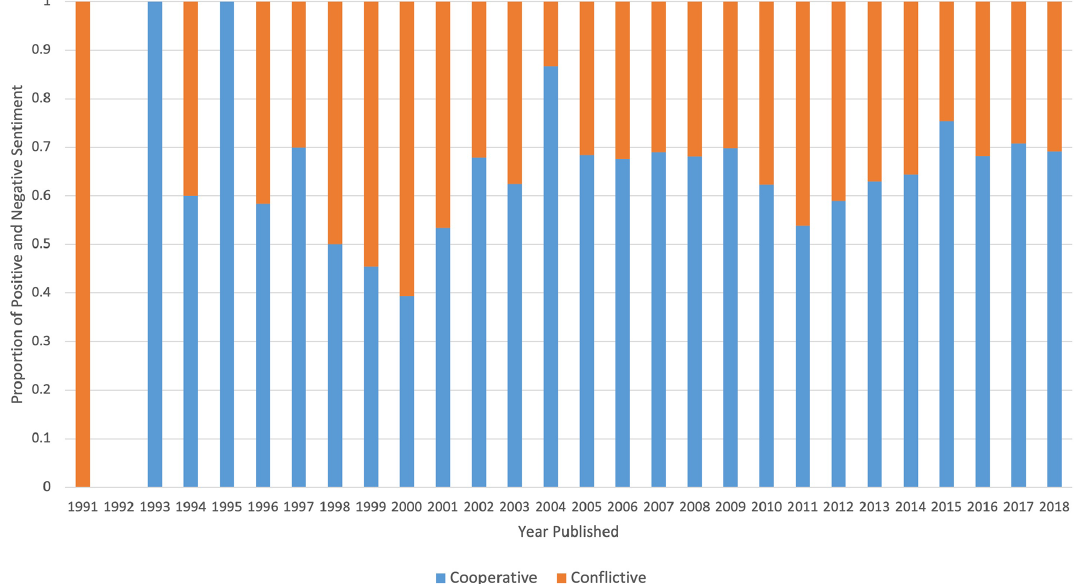
Figure 4. Proportion of cooperation and conflict articles published pertaining to water events along the Lancang–Mekong River